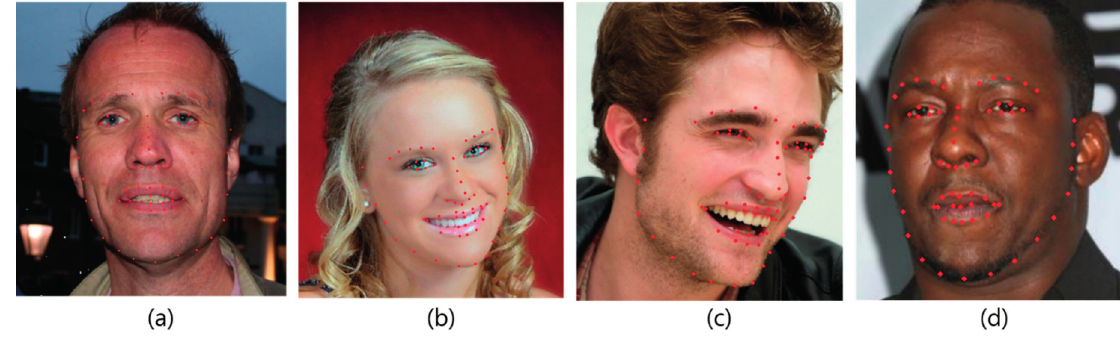
Figure 2. Examples of trained databases. Red points represent 68 annotated